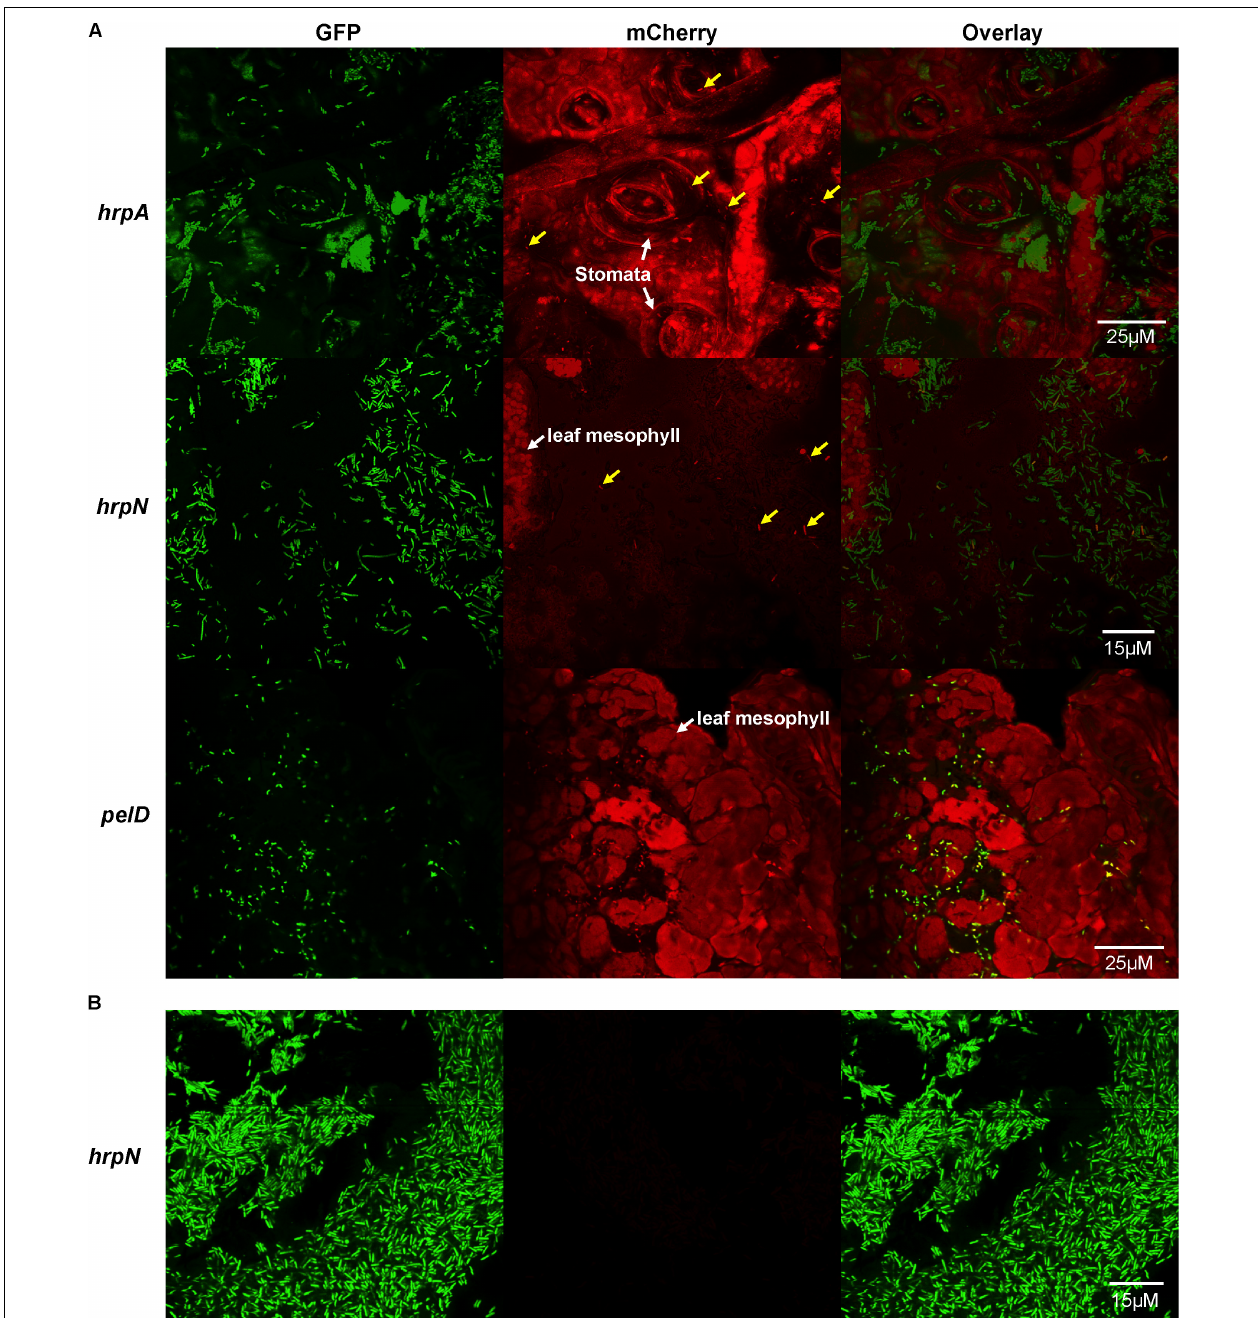
FIGURE 1 | Confocal microscopy observation of T3SS gene expression, as defined by promoter activities of hrpA , hrpN , and pelD (a non-T3SS control), in single cells of D. dadantii in potato leaves. (A) Promoter activities of hrpA , hrpN , and pelD in D. dadantii in potato leaves. (B) Promoter activity of hrpN in LB broth. Potato leaves were infiltrated with D. dadantii carrying dual different fluorescence reporter plasmids, nptII-gfp-hrpA-mCherry , nptII-gfp-hrpN-mCherry , or nptII-gfp-pelD-mCherry , respectively. Leaves with water soaking symptoms 24 h after inoculation were dissected and observed under a confocal microscope. D. dadantii carrying nptII-gfp-hrpN-mCherry plasmid was cultured in LB broth for 18 h prior to observation. Left panel: GFP fluorescence. Middle panel: mCherry fluorescence. Right panel: overlay of GFP and